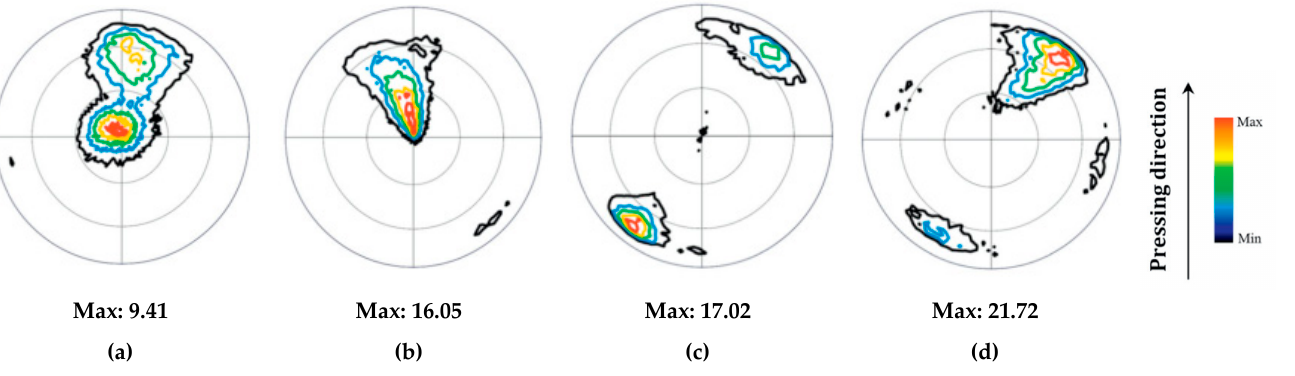
Figure 3. The influences of ECAP technique on texture evolution (pole figures) “Reused with permission from Elsevier by License No. 5494610777006” [42]; ( a ) Extruded; ( b ) 1 pass; ( c ) 2 passes; ( d ) 6 passes.